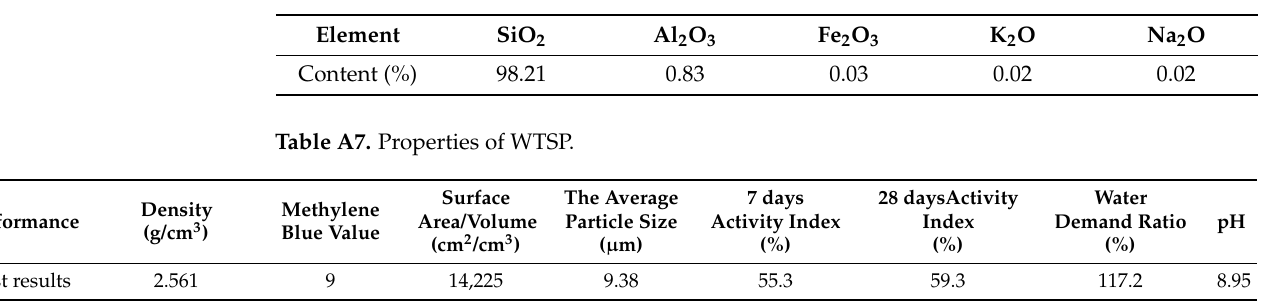
Table A6. Chemical composition analysis of quartz sand.